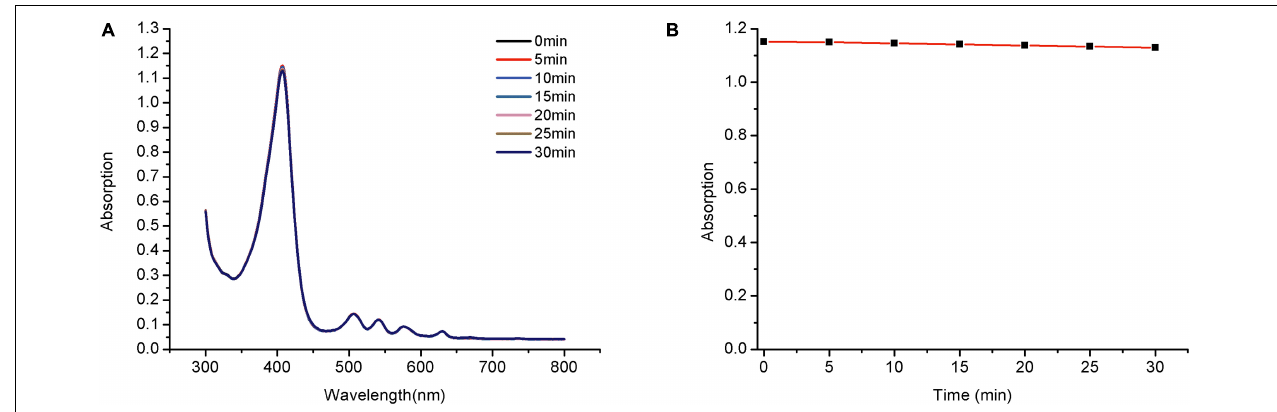
FIGURE 3 | Photobleaching of PPIX-MED. Photostability of PPIX-MED with irradiation time (2 × 10 - 5 mol/l PPIX-MED, 0.2 J/cm 2 per min). (A) The absorption spectrum of compound PPIX-MED from 0 to 30 min. (B) The absorbance change of compound PPIX-MED against irradiation time at the maximum absorption wavelength.